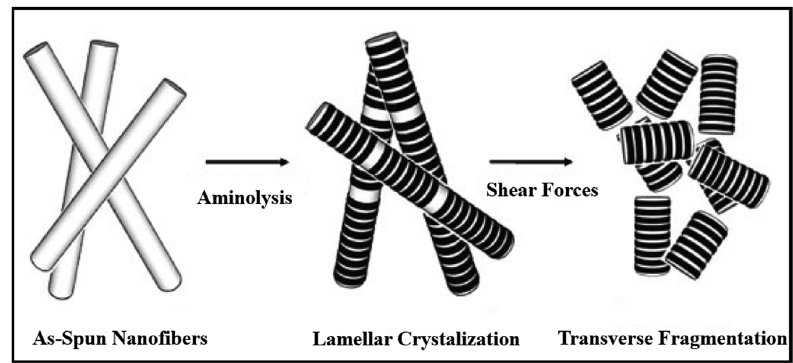
Figure 7: Aminolysis - induced fragmentation and crystallization of PLA nano fi bers [ 23 ] ; Copyright 2018, reproduced with permission from John Wiley and